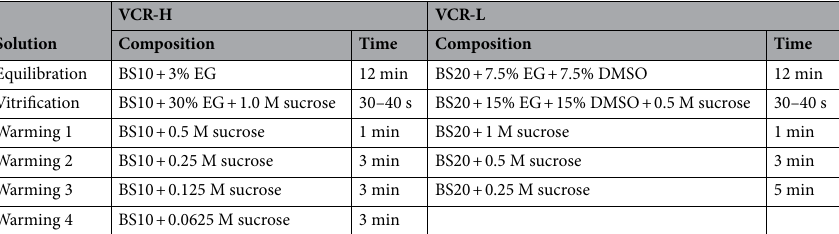
Table 7. Summary of vitrification protocols. The base solution contained Hepes-TCM-199 Hank’s with 10% (v/v) (BS10) or 20% (v/v) (BS20) foetal bovine serum. For vitrification, oocytes were placed in 500 μL of equilibration solution (ES) for 10–15 min. and in 100 μL of vitrification solution (VS) for 15 s, then the cryo- device was loaded and plunged in liquid nitrogen (total exposure to VS of 40 s). For warming, oocytes were immersed in 4 mL of warming solution, then washed in 500 µL of the different warming solutions depending on the protocol. After the last warming solution, oocytes were washed two times in BS10 or BS20. EG: ethylene glycol; DMSO: dimethyl sulfoxide. M: mol/L. VCR-H: corona radiata oocytes vitrified with a protocol using high concentrations of cryoprotectants (15%) in equilibration solution; VCR-L : corona radiata oocytes vitrified with a protocol using a low cryoprotectant concentration (3%) in equilibration